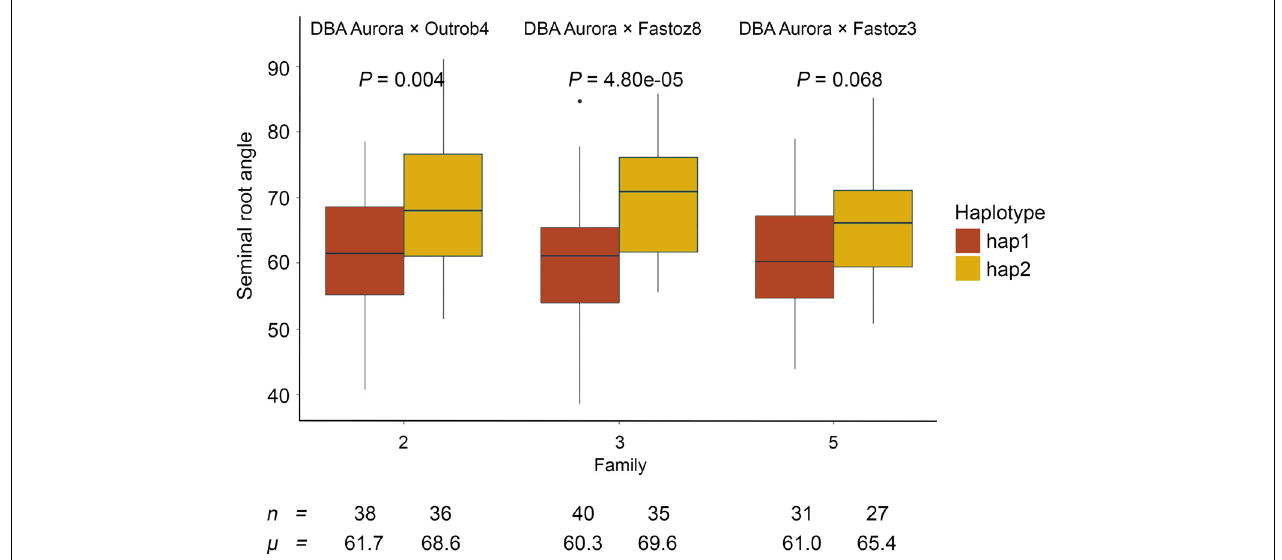
FIGURE 6 | Seminal root angle measurements in three NAM families segregating for the most common haplotype of the QTL qSRA-6A . Families were derived from crosses between DBA Aurora to three ICARDA lines (Outrob4, Fastoz3, and Fastoz8). In each family, mean SRA value of individuals carrying hap1 and hap2 was compared. The colors represent the two haplotype groups, n represents the number of individuals carrying different haplotype groups, µ represents the mean SRA value of each haplotype group, and P represents significance from an Honestly Significant Difference (HSD) test for the difference between the two haplotype groups within each family.